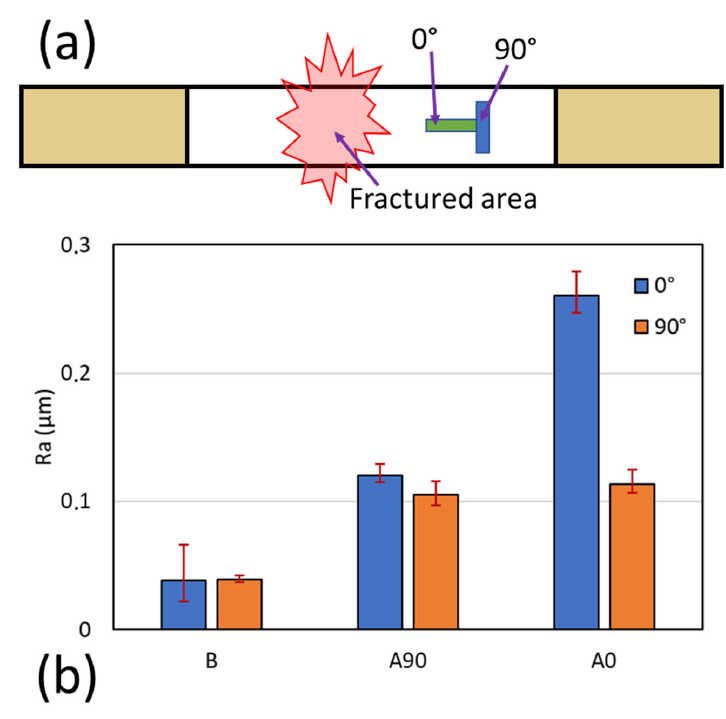
Figure 7. ( a ) The area’s position for gathering surface roughness data. ( b ) Ra results of the specimen. B is the specimen before the test, A90 is the [90/0] S specimen, and A0 is the [0/90] S specimen.